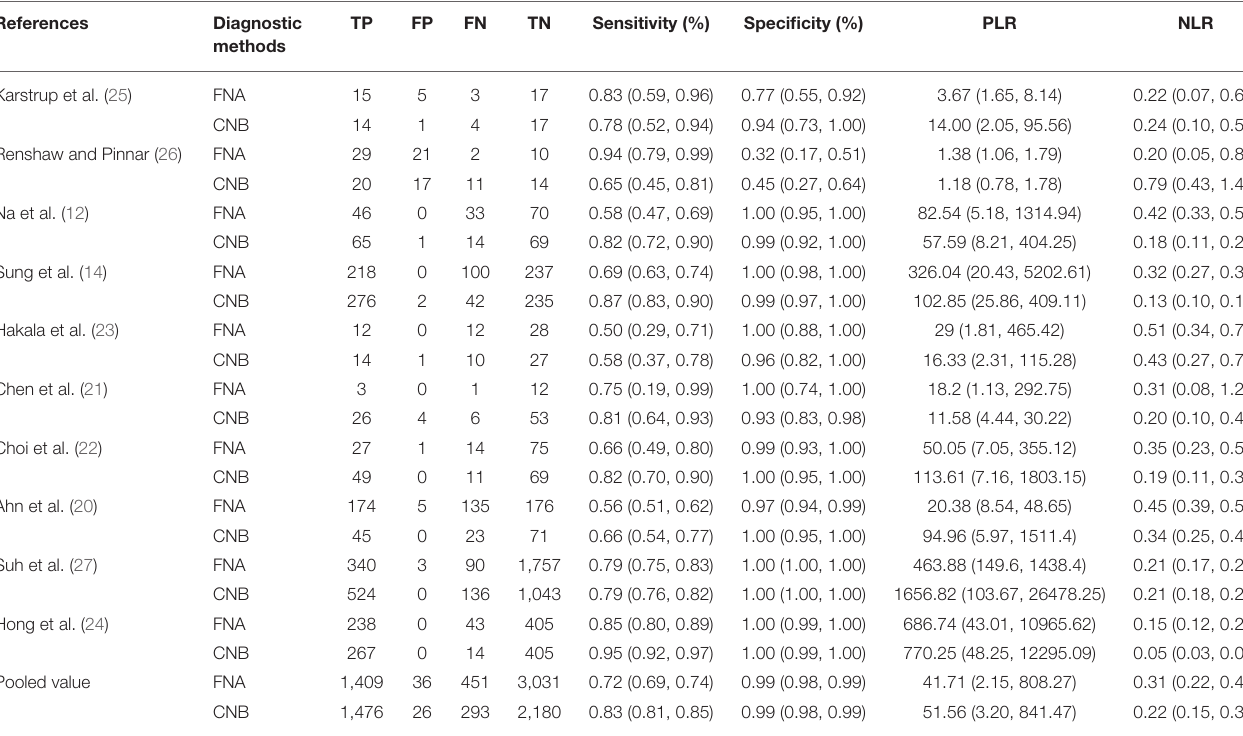
TABLE 2 | Summary of results of the studies included in this